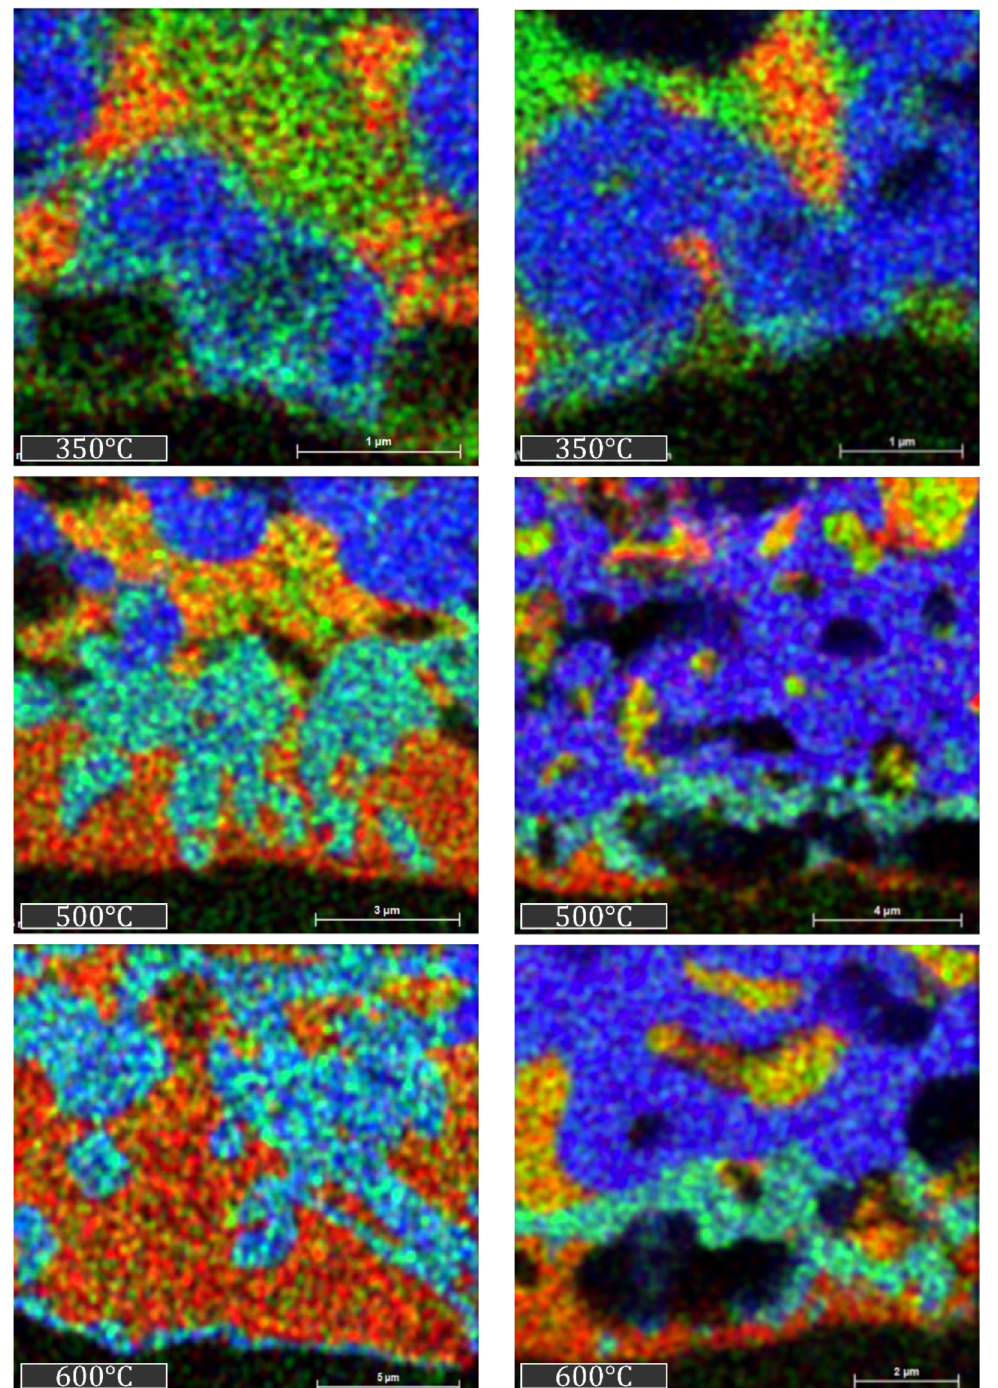
Fig. 5. EDX cross section maps of pastes on non-coated silicon for different RTP fi ring peak temperatures on the left side for an Ag:MO ratio of 50%:50% and on the right side of 75%:25%. Dark blue depicts here the silver intensity, green tellurium and red bismuth. A co-mapping is clearly visible for higher temperatures indicated by the color mix. Also, the movement of Te upwards and Bi downwards is